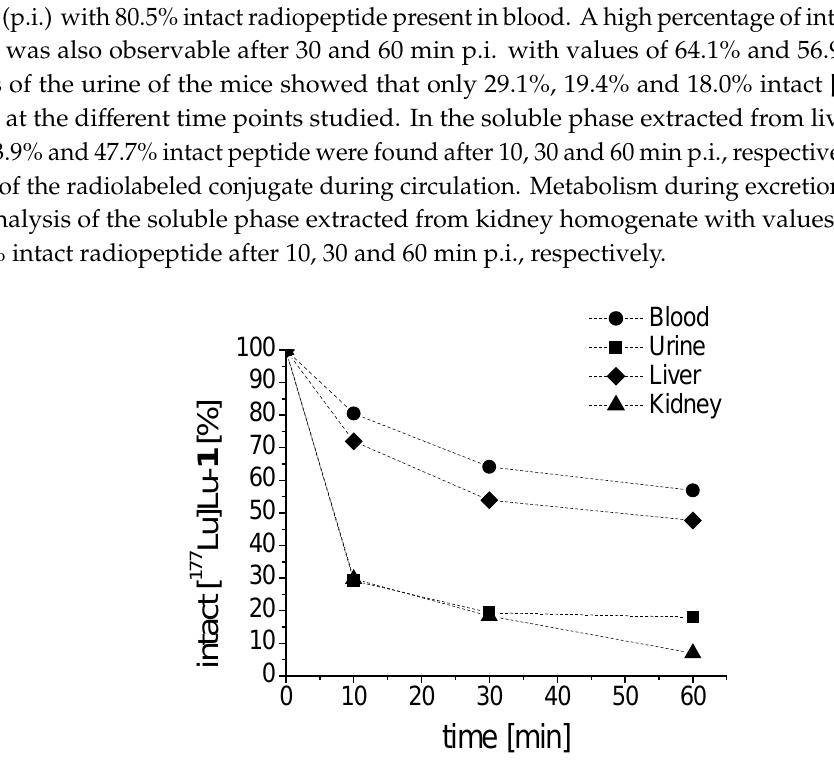
Figure 5. Competitive binding curves against [ 125 I][3-iodo-Tyr 12 ,Leu 15 ]gastrin-I for ( a ) non-labeled 1 in comparison with pentagastrin, as well as ( b ) non-labeled M1 – M4.